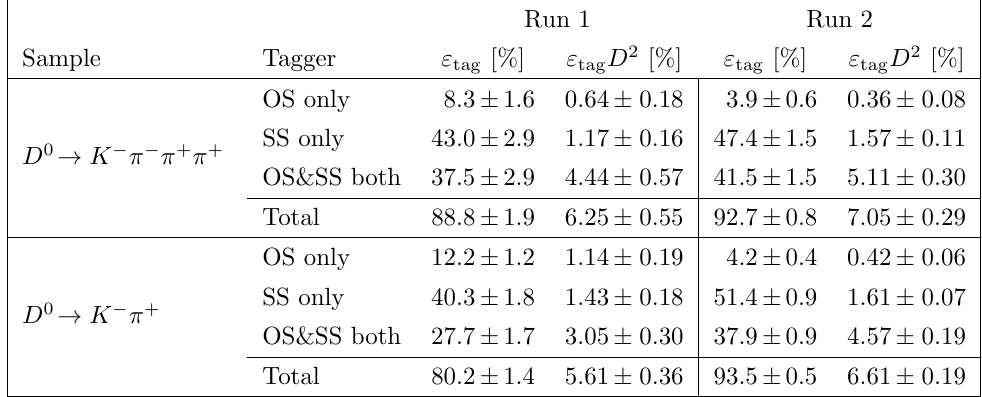
Table 2 . Tagging e(cid:14)ciency and tagging power for B 0 D (cid:3)(cid:6) D (cid:7) signal candidates in the four data ! samples, computed using the event-by-event predicted mistag (cid:17) and the calibration parameters obtained from control channels. The quoted uncertainties are statistical